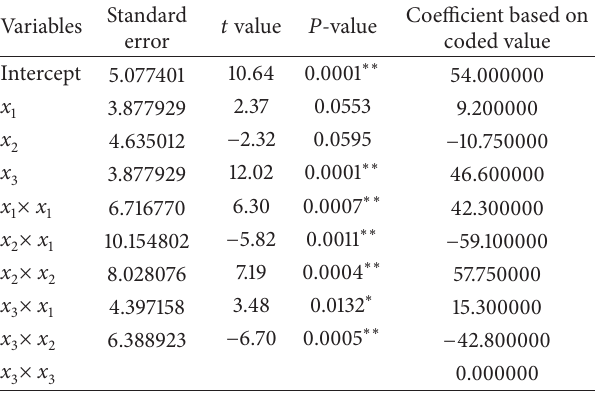
Table 5: Regression analysis of a full second-order polynomial model for optimisation of glucose production from OPEFB cellu- lose.